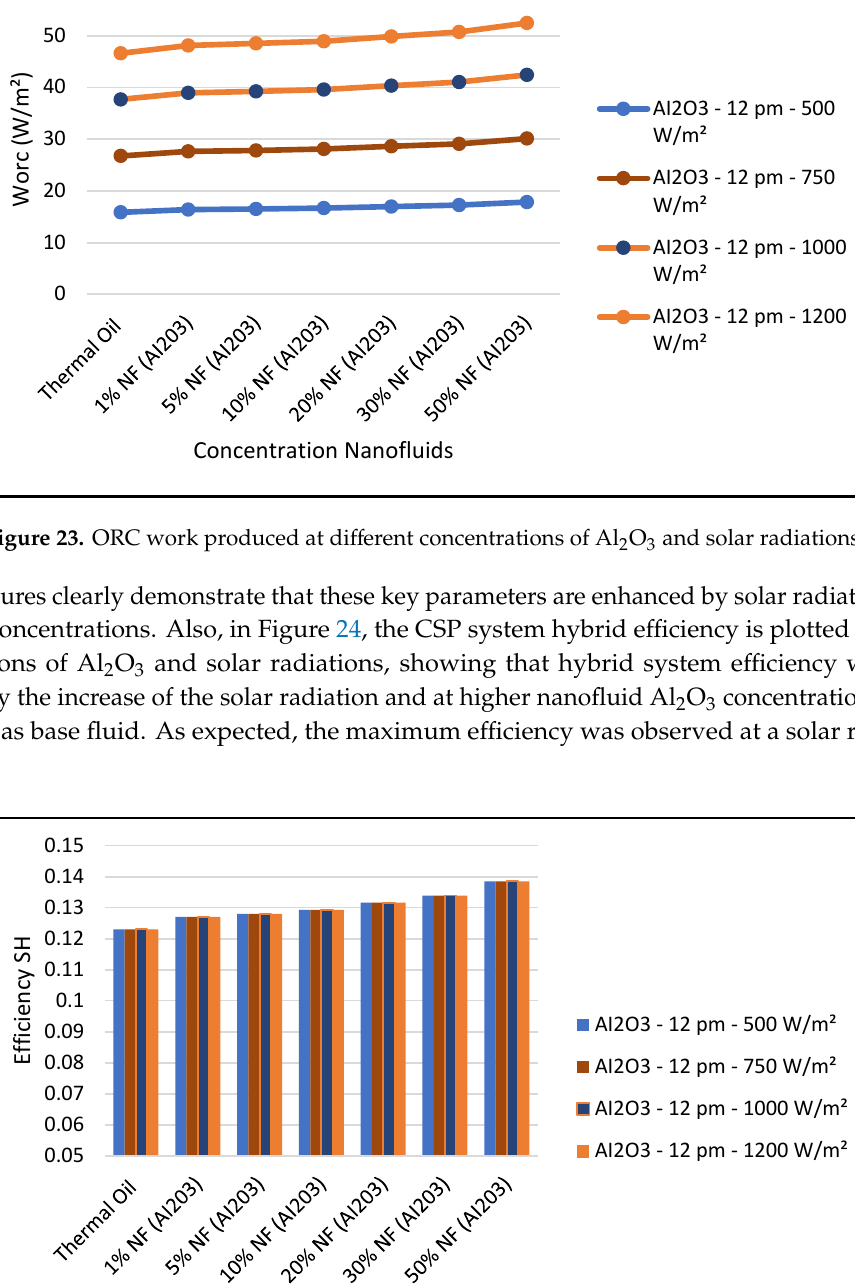
Figure 24. CSP system hybrid efficiency at different concentrations of Al 2 O 3 and solar radiations.